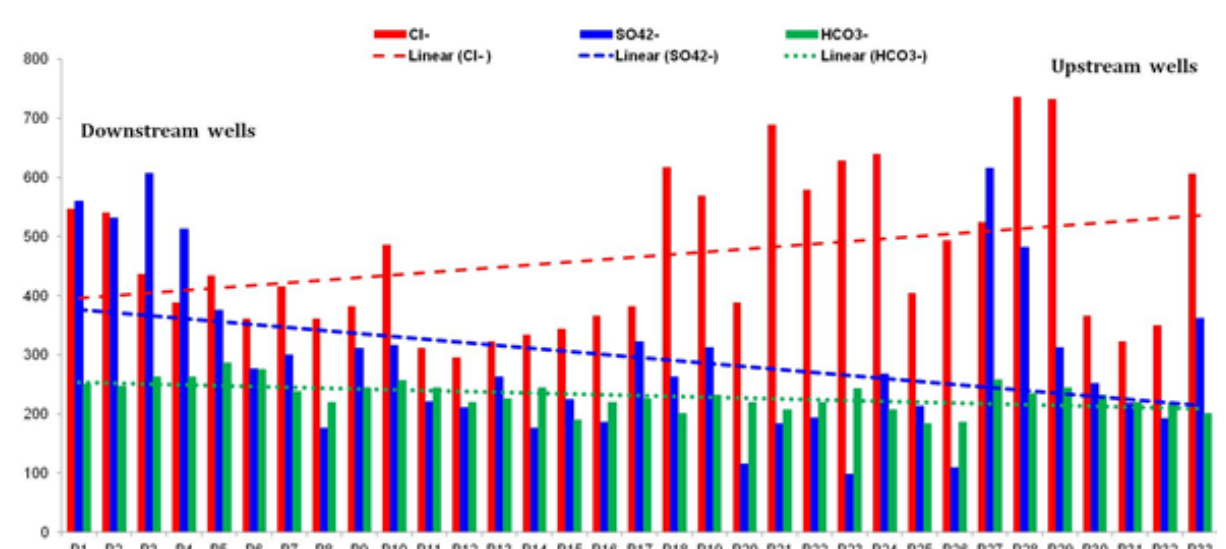
Fig. 4. Distribution of the Ca 2+ , Mg 2+ , and Na + cations in the study area